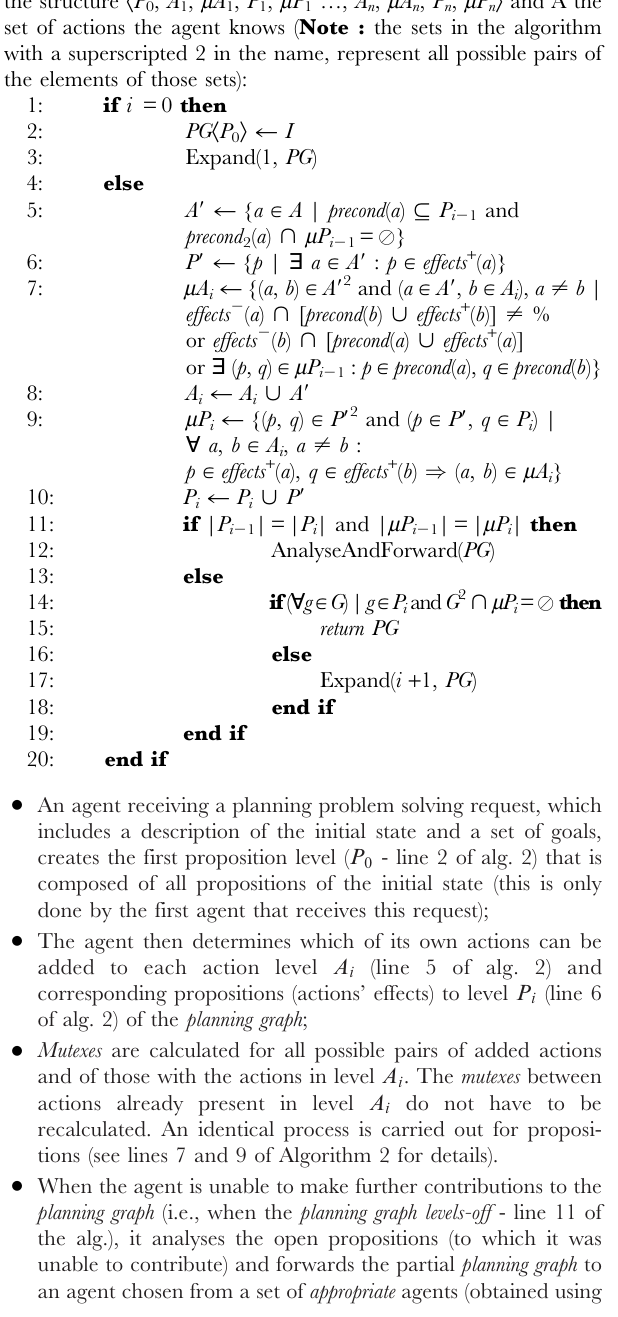
Algorithm 2 Expand(i, PG): Let i be the current level of expansion in the planning graph, I the set of propositions in the initial state, G the set of goal propositions, PG a planning graph with the structure Æ P 0 , A 1 , m A 1 , P 1 , m P 1 …, A n , m A n , P n , m P n æ and A the set of actions the agent knows ( Note : the sets in the algorithm with a superscripted 2 in the name, represent all possible pairs of the elements of those sets):